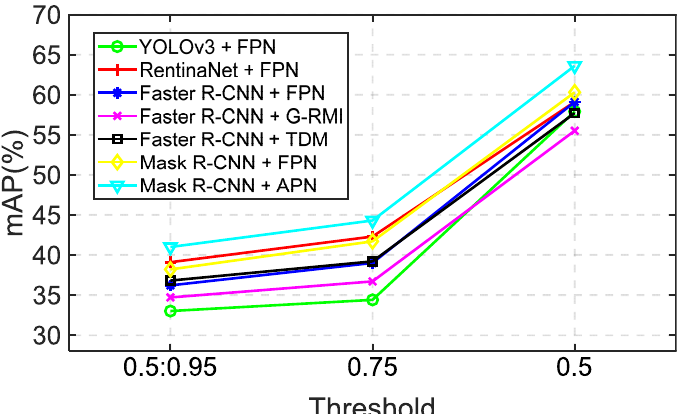
Figure 4. Mean Average Precision of the proposed APN-based model and FPN-based models in different